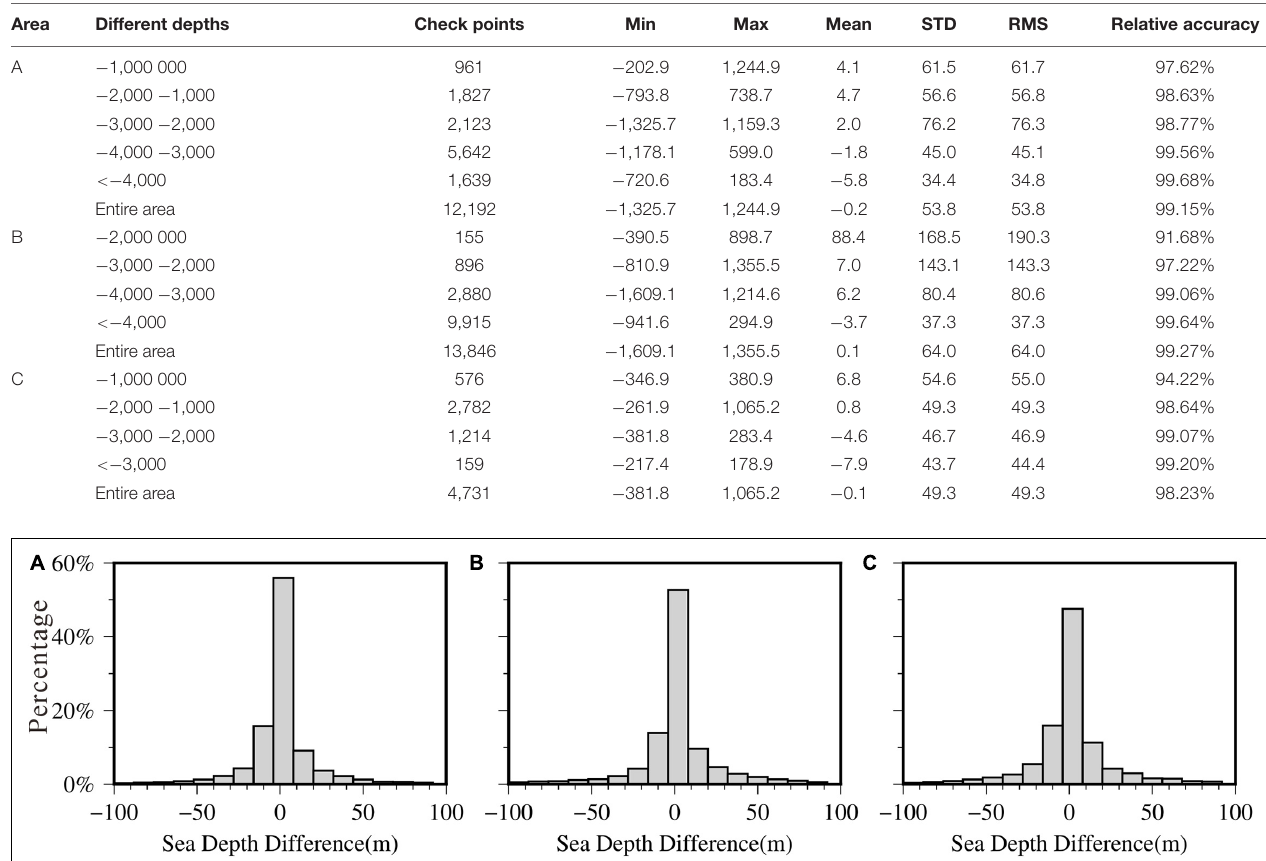
TABLE 3 | Statistics of different depths between the NCEI bathymetry and the GGM bathymetry in the check points (unit: m). Area Different depths